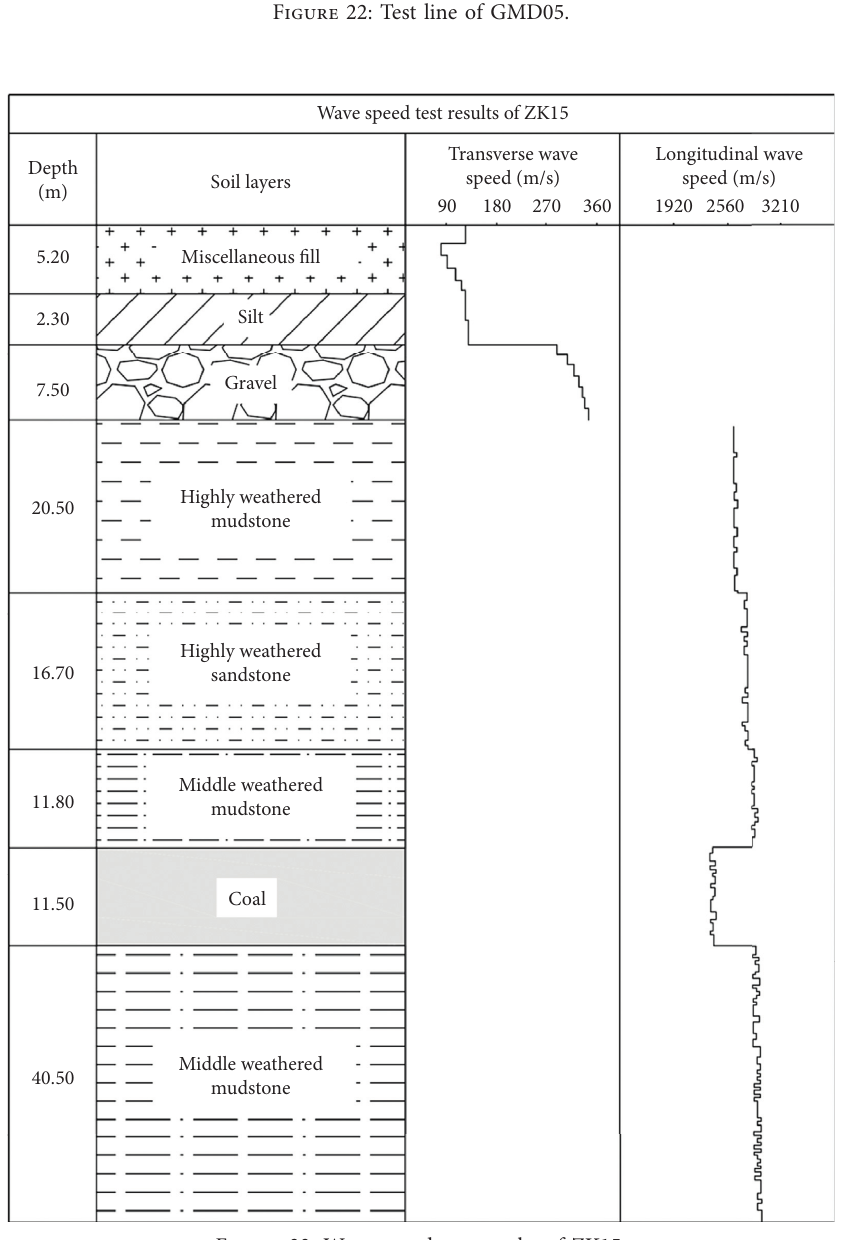
Figure 23: Wave speed test results of